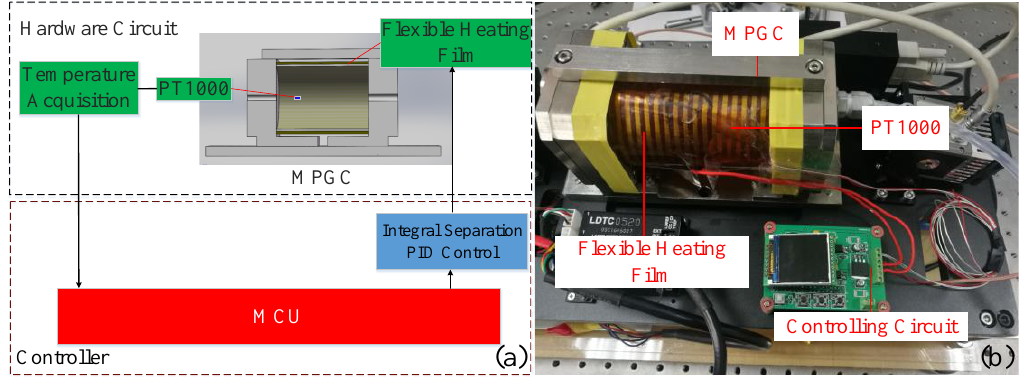
Figure 3. ( a ) Schematic block diagram of the temperature control system for the multi-pass gas cell (MPGC), which includes a controller and hardware circuit. ( b ) Physical image of the temperature control system including a PT1000 temperature sensor, flexible heating film, and controlling circuit.